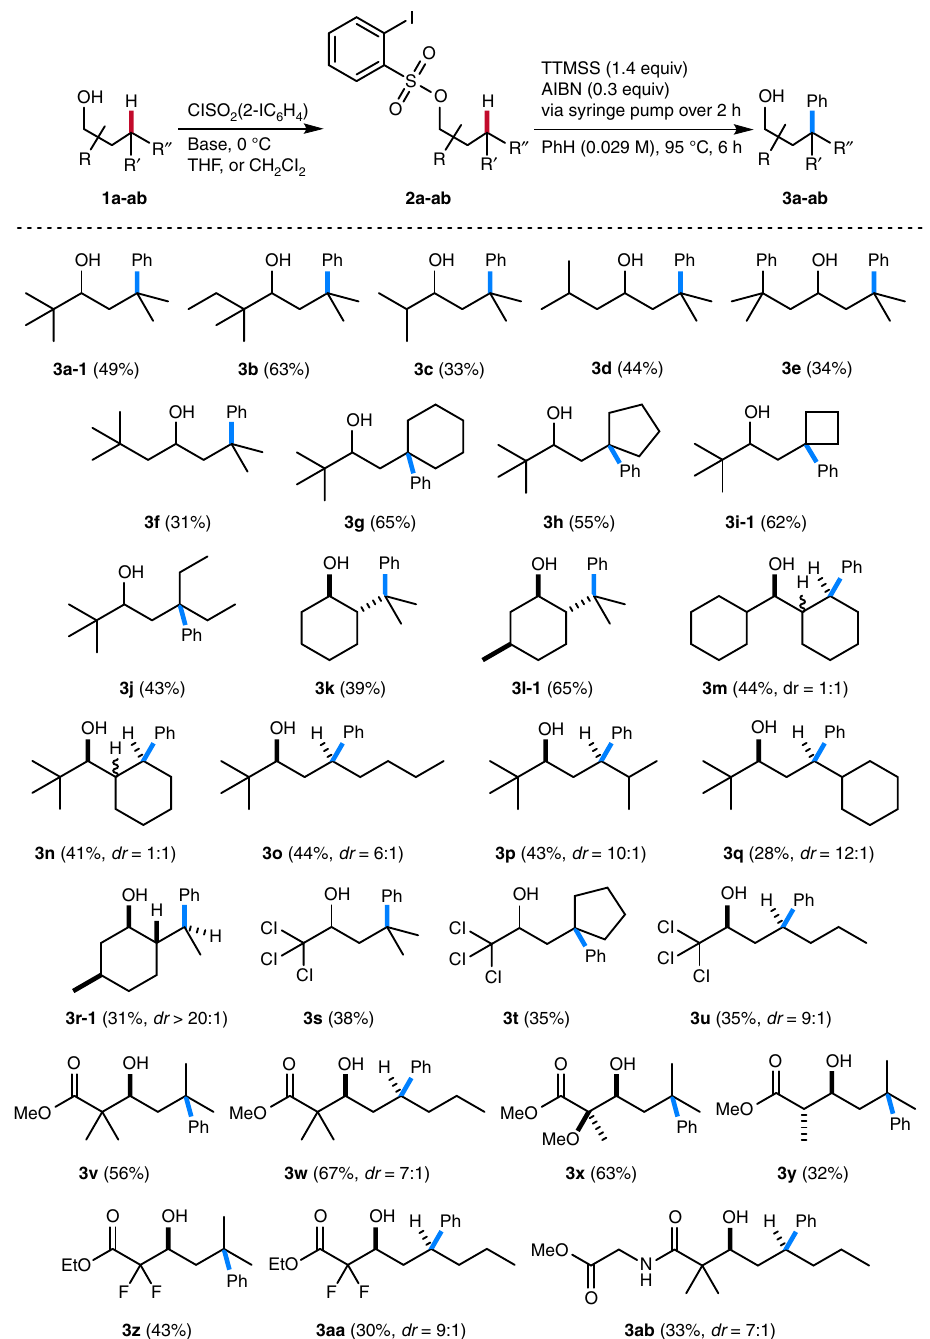
Fig. 2 Remote C − H phenylation via radical generation, translocation, and phenyl migration. Sulfonylation conditions: ClSO 2 Aryl, Me 3 N·HCl, Et 3 N, ROH in CH 2 Cl 2 at 0 °C or ClSO 2 Aryl, Me 3 N, ROLi in THF at 0 °C, see Supplementary Methods. Variation of the alcohol. Phenylation of tertiary and secondary C(sp 3 ) − H bonds. For the latter, moderate to excellent stereoselectivities are obtained and only the major diastereoisomer is drawn, if applicable (Fig.